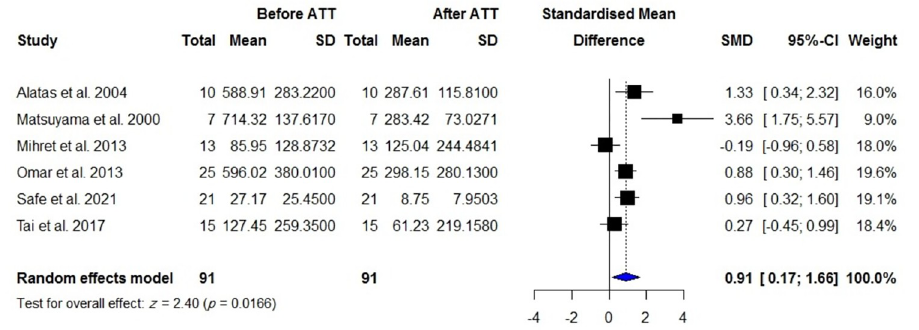
Fig 6. Meta-analysis of pre-post treatment levels of blood VEGF in patients with TB.